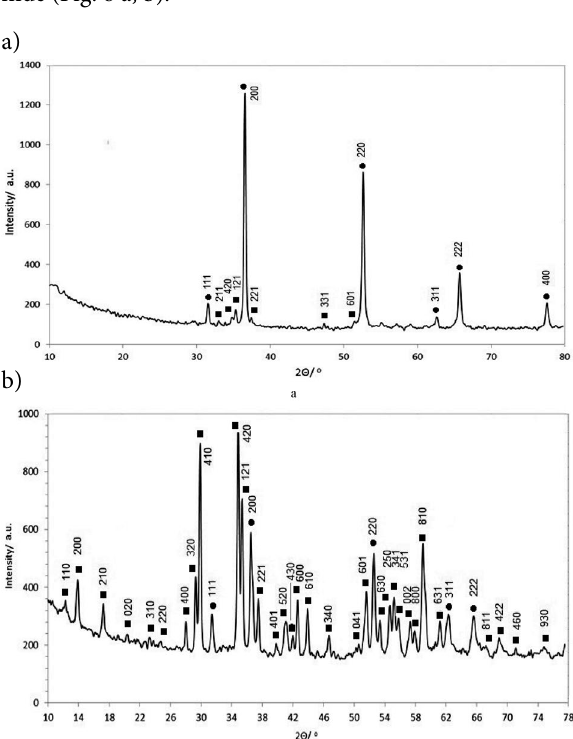
Figure 8. XRD patterns of the alloys of the polythermal section SnAs–GeAs 2 : a – 0.25; b – 0.85 mol.f. GeAs 2 . The symbols denote:  – SnAs;  – GeAs 2 .